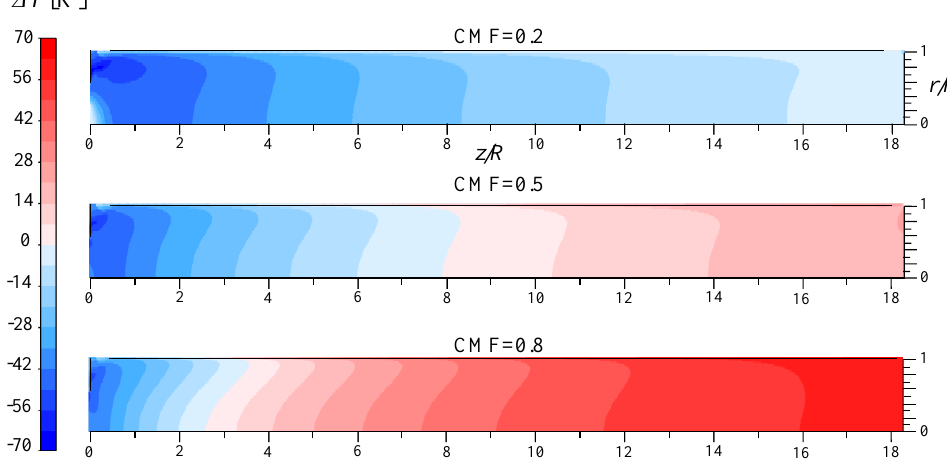
Figure 7. Temperature difference contours for different cold mass fractions.